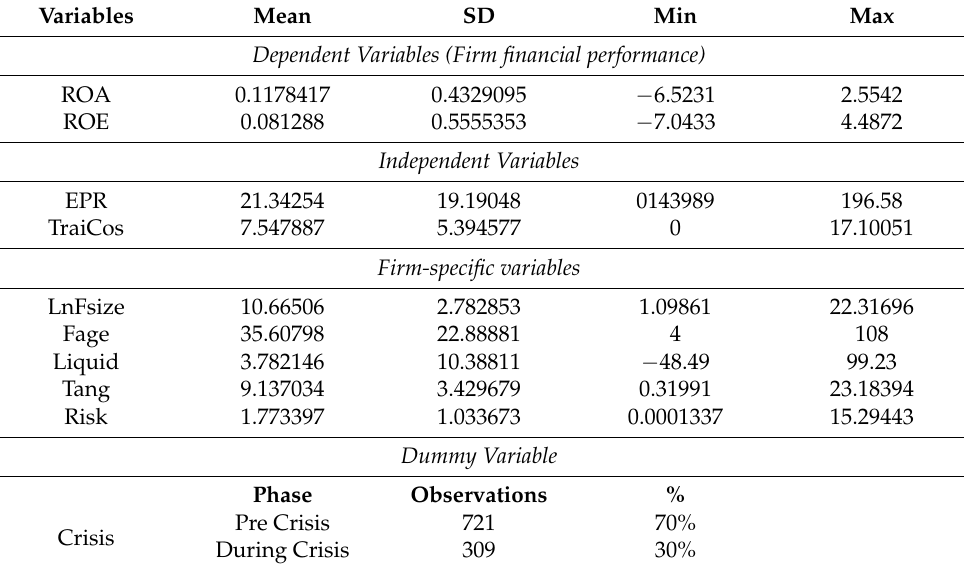
Table 1. Descriptive statistics of financial performance measure and independent